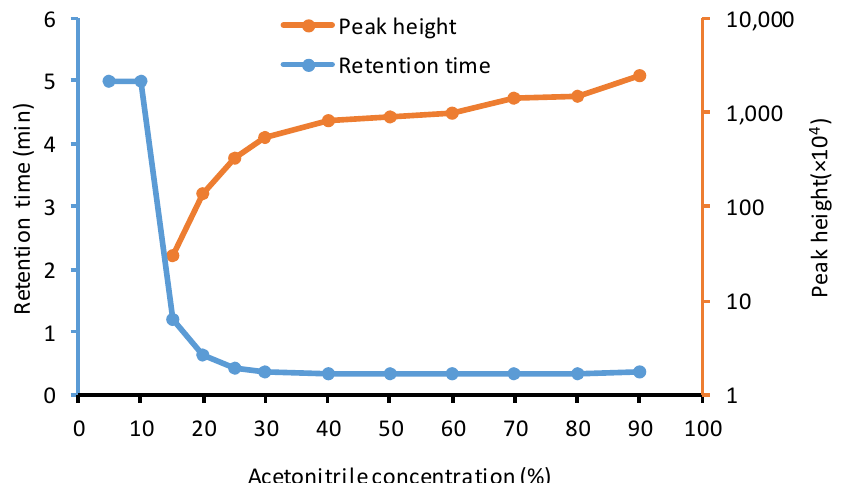
Figure 5. The peak height and retention time of MPI8 (100 ng/mL) on a Kinetex HILIC column in isocratic elution at different concentrations of the mobile phase component of acetonitrile, from 5% to 90%. When the acetonitrile composition in the mobile phase was less than 10%, MPI8 was completely retained on the column, and the retention time mark was 5 min, which was the total running time of the